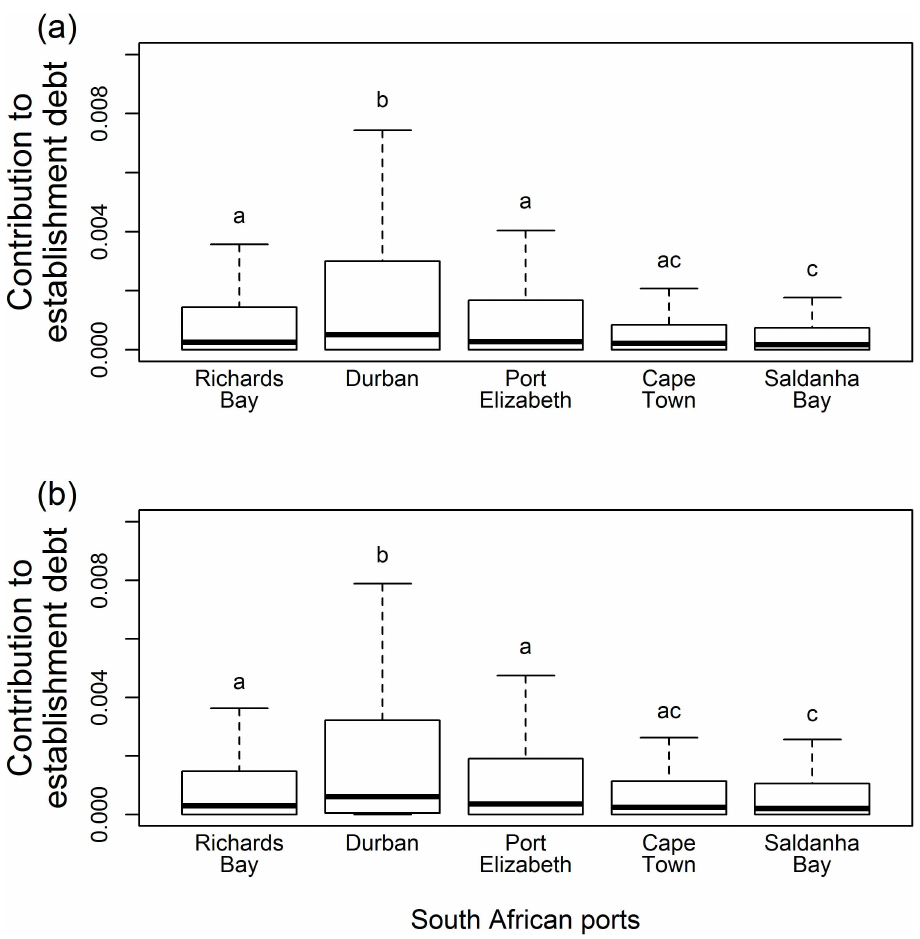
Fig 1. The relativecontributionof shippingroutes from foreign ports to South African ports to (a) marine (Kruskal-Wallis: χ 2 = 59.33, df = 4, P < 0.001) and (b) terrestrial (Kruskal-Wallis: χ 2 = 83.23, df = 4, P < 0.001) establishment debt. Different lower case letters indicate significantdifferences amongst the South African ports. Boxplots represent median and interquartile range.